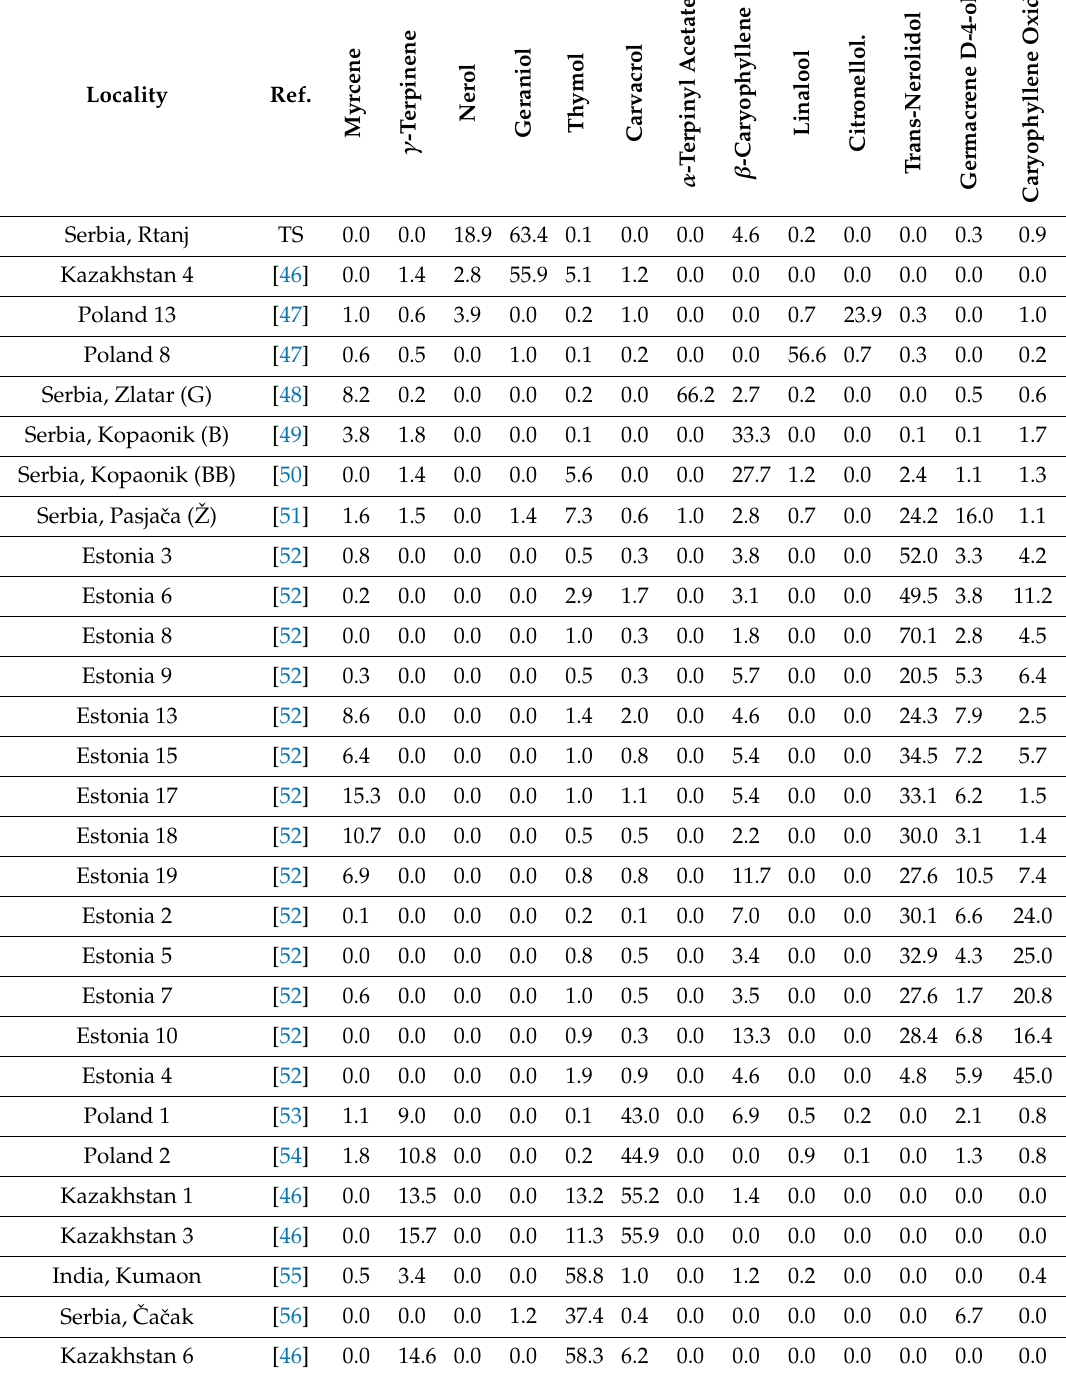
Table 4. The essential oil constituents of other T. serpyllum reported in the